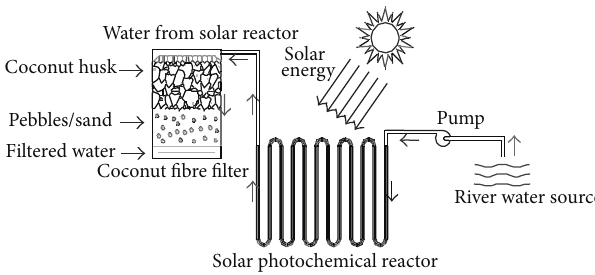
Figure 8: Post-solar photochemical disinfection treatment using coconut-husk fibres for photosensitized dye absorption and filtra-